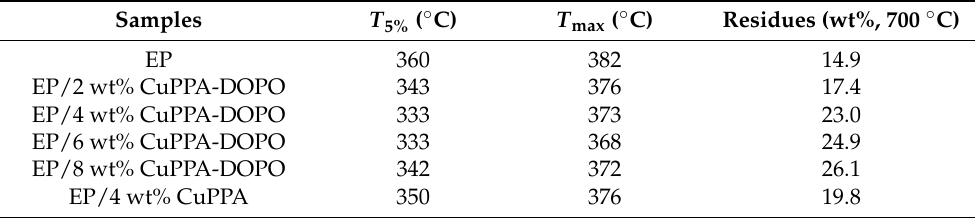
Figure 3. ( a ) TGA and ( b ) DTG curves of pure EP and EP composites. Table 1. TGA data of pure EP and EP composites.